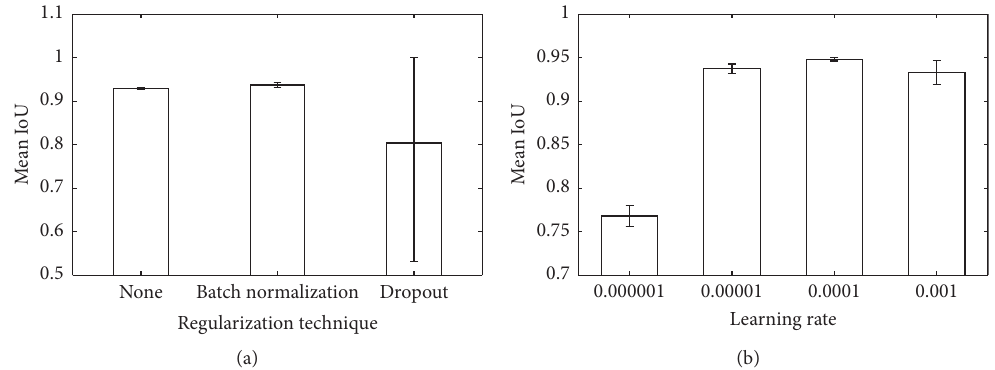
Figure 8: Validation performance with different (a) regularization strategies and (b) learning